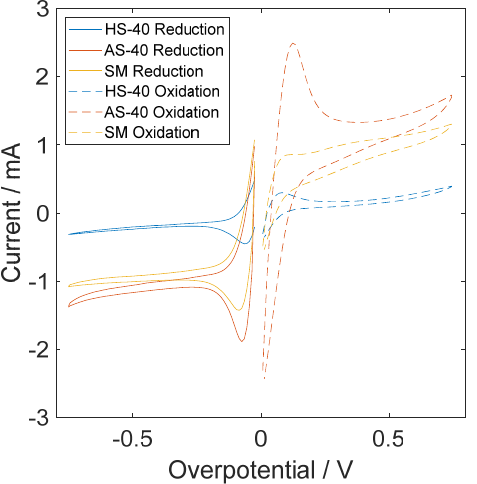
Figure 4. Results of CV measurements with sensor in positive electrolyte with different coatings.